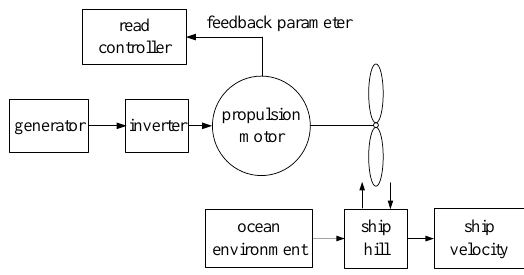
Figure 1. Relationship of ship, motor, and